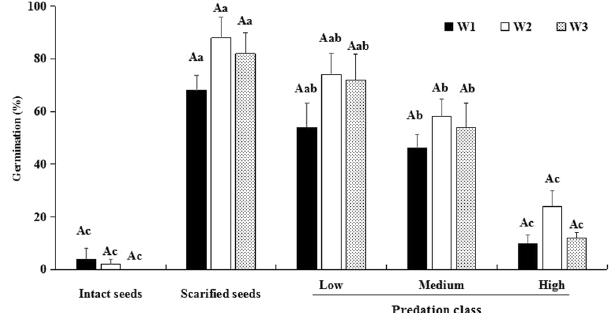
Figure 5. Germination (mean % + se) of intact, scarified and of the three classes of seed predation of Astragalus lehmannianus under different water conditions. W1, natural precipitation; W2, watered only until germination occurred; W3, watered until 1 September 2016. Same uppercase letters indicate no significant differences between watering regime in the same seed treatment ( P > 0.05), and different lowercase letters indicate significant differences between seed treatments in the same watering regime across the five treatments. ( P < 0.05).